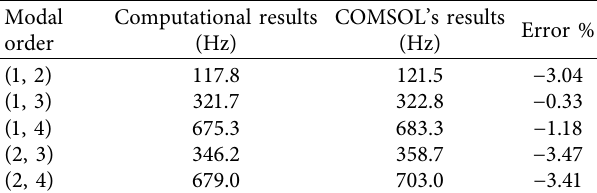
Table 3: Natural frequencies of double-sided water immersion